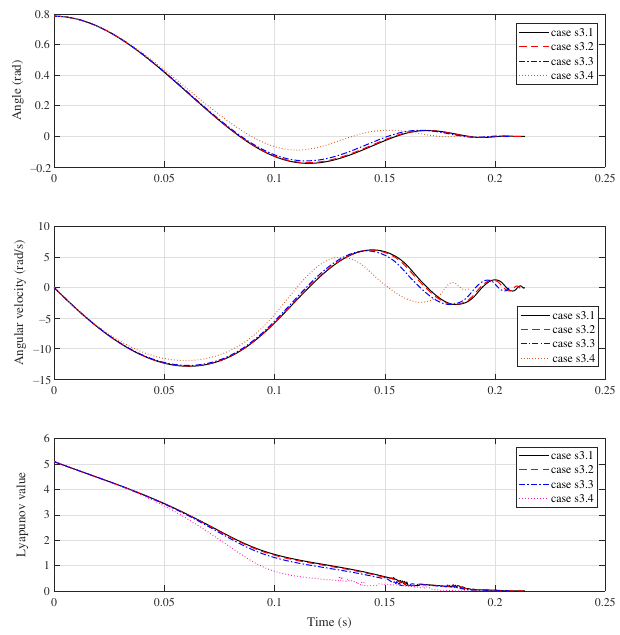
Figure 6. System response of Group